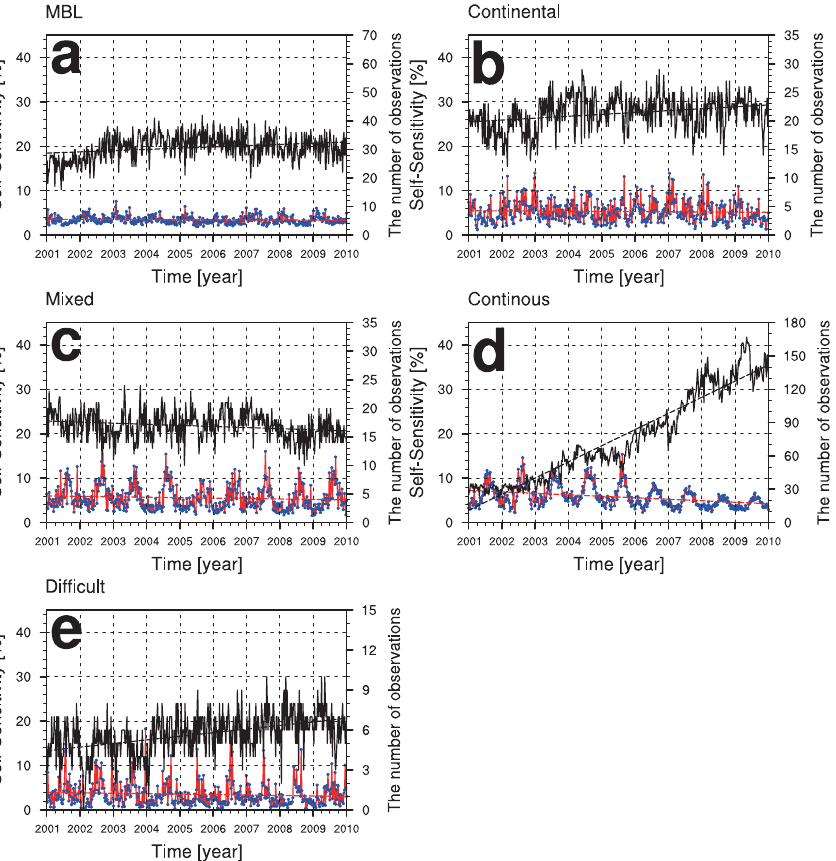
Figure 7. Time series of the average self-sensitivity (red solid line with blue dots) and the number of observations (black solid line) with a weekly temporal resolution for the (a) MBL, (b) Continental, (c) Mixed, (d) Continuous, and (e) Difficult observation site categories from 2001 to 2009. The dashed lines represent the regression lines for the average self-sensitivity (red dashed line) and the number of observations (black dashed